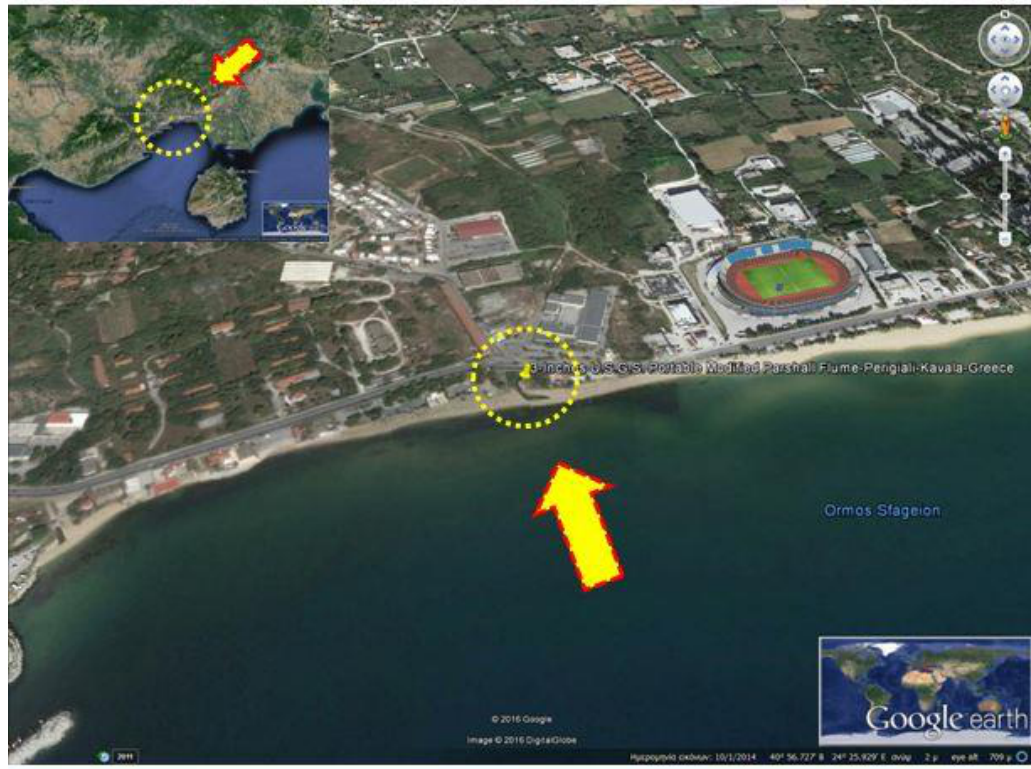
Figure 1. Parshall flumes and V-Notched weir gauging station, Perigiali Stream area, Kavala city,